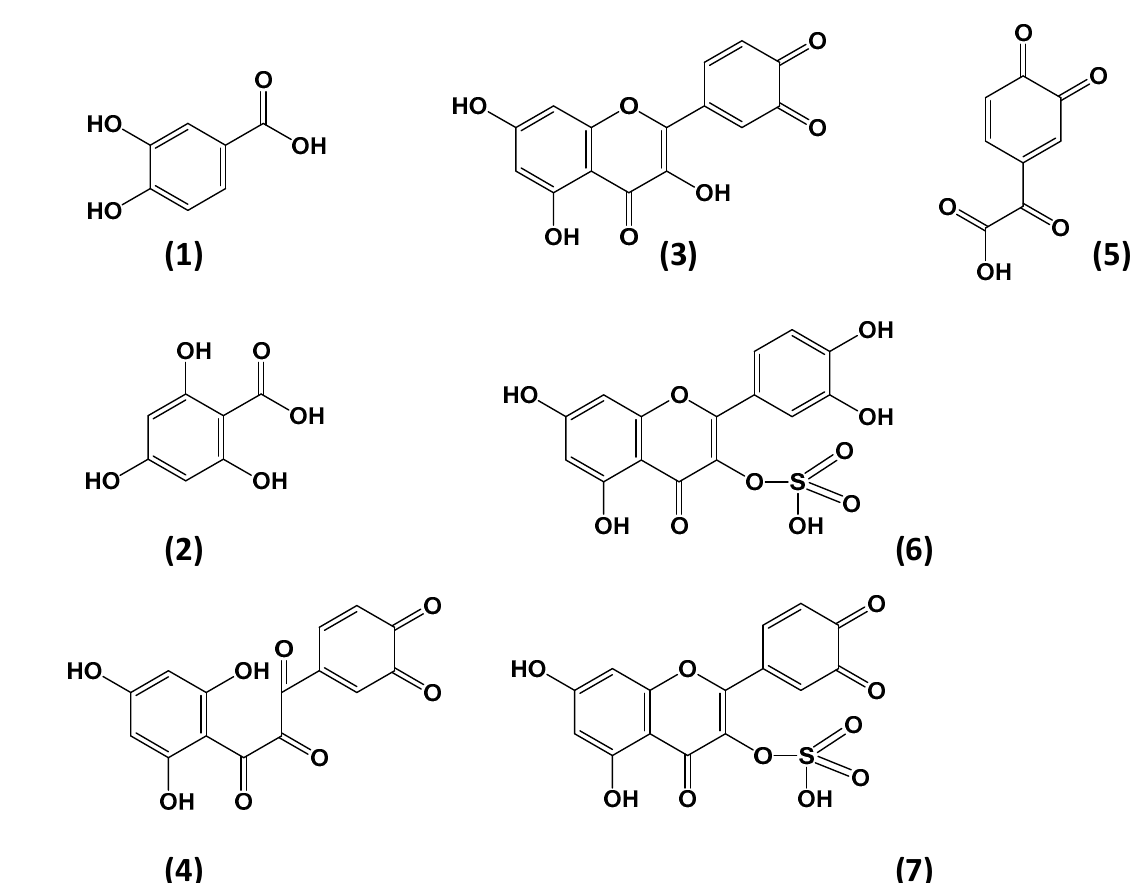
Figure 3. Structures of Qt degradation/oxidation/reaction products tentatively identified in the model solutions tested. Assignments: ( 1 ) Protocatechuic acid ( m / z = 151); ( 2 ) phloroglucinol carboxylic acid ( m / z = 169); ( 3 ) Qt quinone ( m / z = 299); ( 4 ), 2,3,4,-chalcan-trione o -quinone; ( 5 ) 3,4-dione-2-oxo-phenylacetic acid ( m / z = 179); ( 6 ) Qt 3-sulfate ( m / z = 381); ( 7 ) Qt 3-sulfate quinone ( m / z = 379).